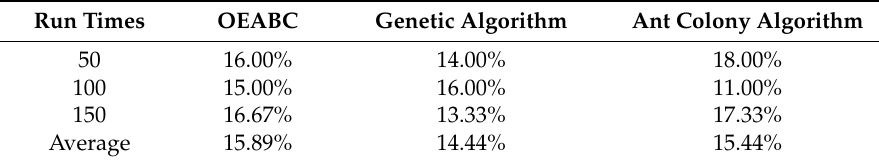
Table 7. The percentage for the appearance of optimal solution.